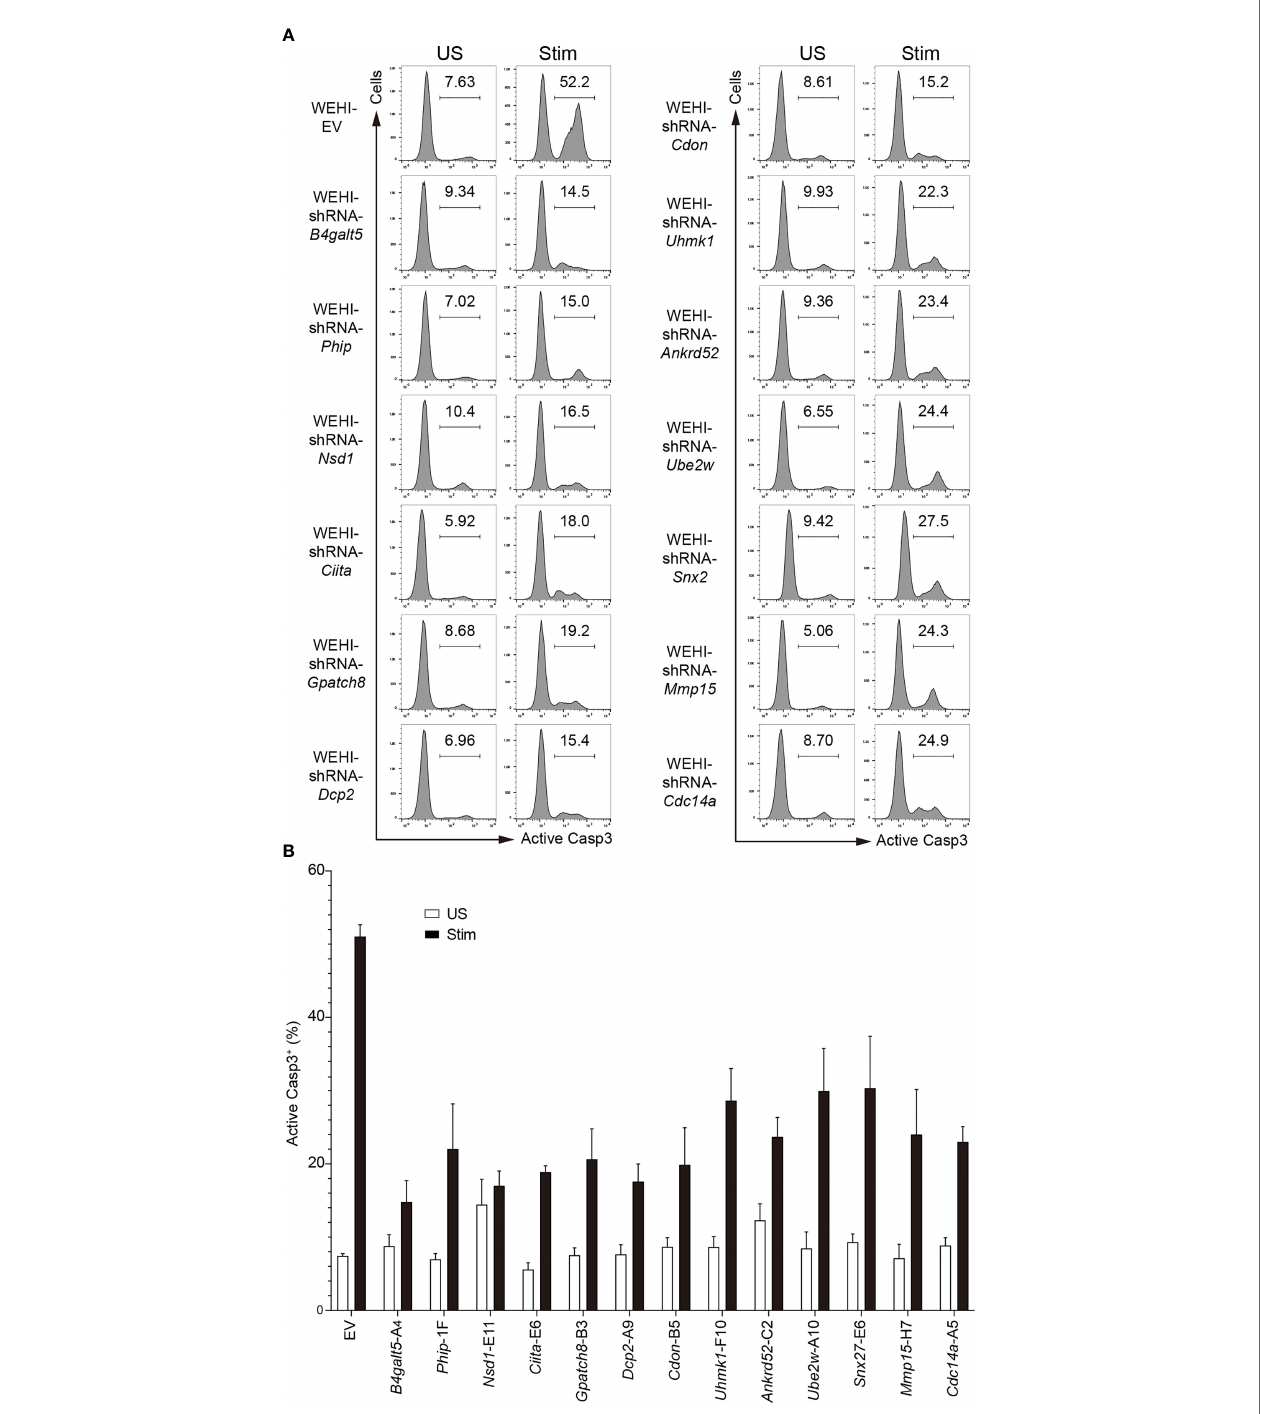
FIGURE 3 | Effect of the top hit shRNAs in the in vitro functional screen. (A) Representative fl ow cytometry histograms showing apoptosis of WEHI-231 transduced with retroviruses encoding shRNAs or empty vector (EV), stimulated for 72 hours with 2µg/ml anti-IgM (Stim) or left unstimulated (US), followed by fl ow cytometry analysis of active caspase 3 (Casp3). (B) Frequency of active caspase-3-positive (Casp3 + ) cells among total cells in (A) . Every independent experiment included an internal WEHI-EV control. A representative WEHI-EV control experiment is shown. Results are pooled from 3 independent experiments for EV, Phip -F1, Nsd1 -E11, Ciita -E6, Dcp2- A9, Cdon -B5 and Cdc14a -A5, 4 for Gpatch8 -B3, Uhmk1 -F10, Ankrd52 -C2, Ube2w -A10 and Snx27 -E6, and 5 for B4galt5 -A4 and Mmp15 -H7. Graph bars indicate mean +